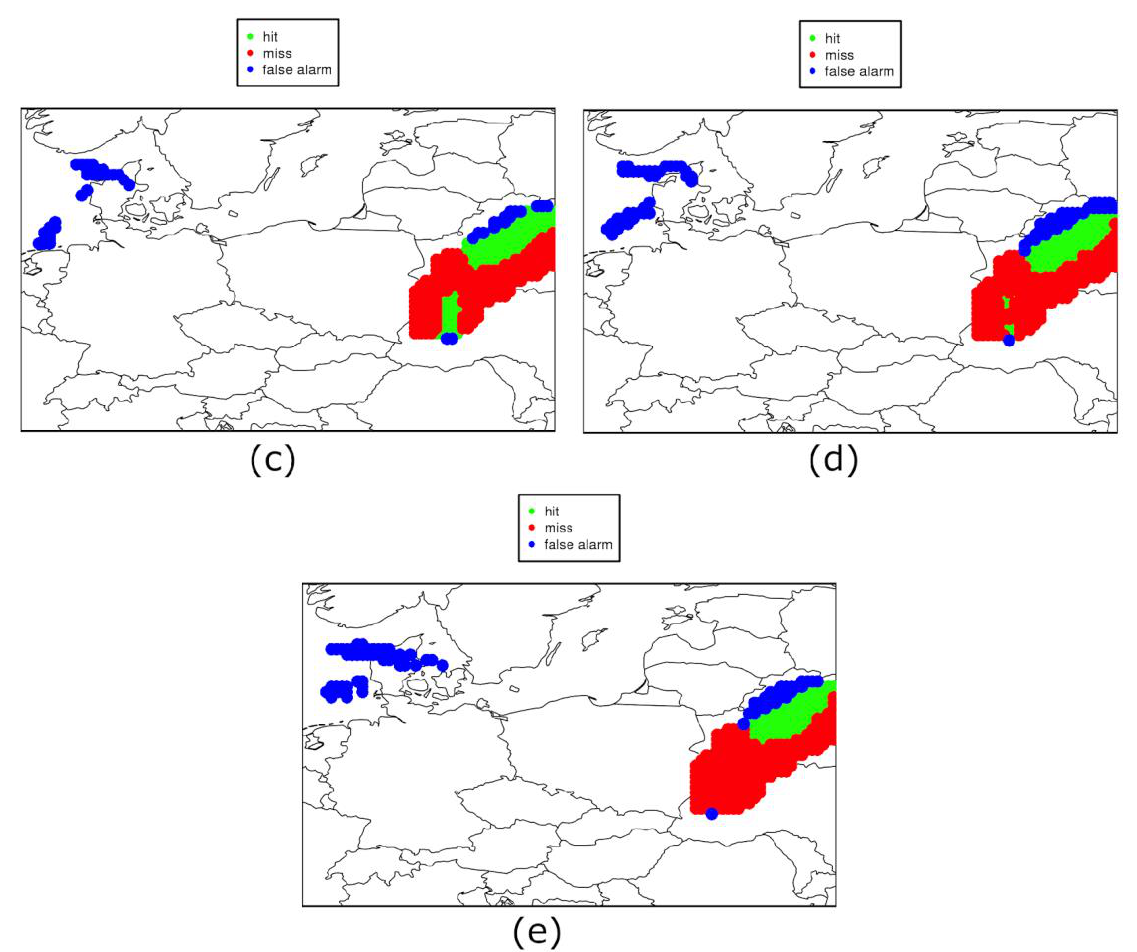
Figure 7. Results of the trained system with respect to using the values of meteorological parameters ( a ); the gradient of the meteorological fields calculated from one surrounding point ( b ); two surrounding points ( c ); three surrounding points ( d ); and four surrounding points ( e ).